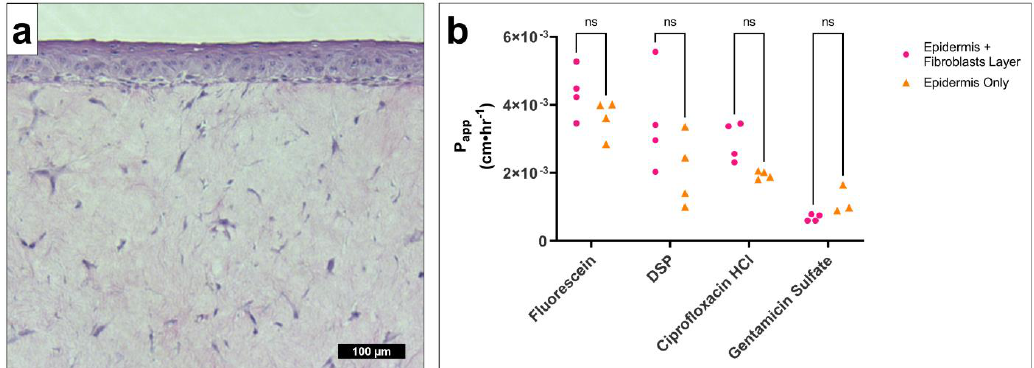
Figure 5. Fibroblast connective tissue layer has no significant effect on drug permeability in the in vitro TM model. ( a ) Representative micrograph of hematoxylin-and-eosin-stained epidermis with an underlying connective tissue layer with embedded fibroblasts. ( b ) P app at approximate steady-state conditions (average of 6 – 24 h timepoints), for fluorescein (0.0033% w/v ), DSP (0.2% w/v Eq), ciprofloxacin HCl (0.2% w/v Eq), and gentamicin sulfate (0.3% w/v Eq) in a TM model containing epidermis with connective tissue/fibroblasts (pink circle) or epidermis only (orange triangle). Underdeveloped tissues were tested (5 days growth) to increase resolution and avoid detection limits artificially reducing of any differences. n = 3–4. Multiple t-tests with Holm–Š í d á k correction for multiple comparisons. DSP, dexamethasone sodium phosphate; Eq, molar equivalent of base compound; ns, not significant; P app , apparent permeability coefficient; TM, tympanic membrane; w/v, weight by